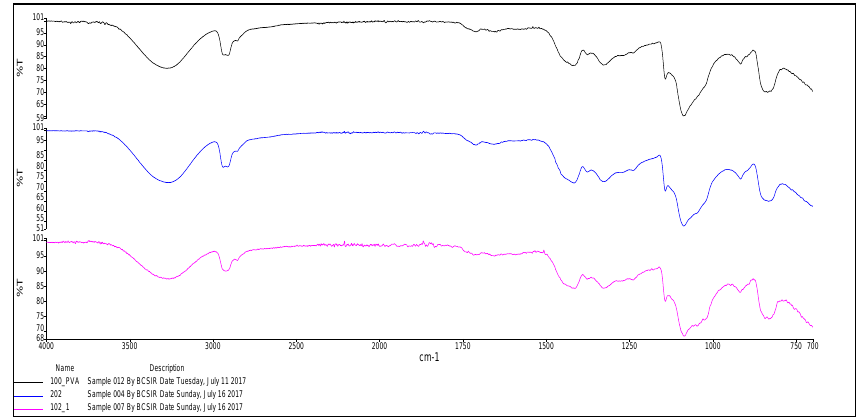
Figure 2. FTIR spectra of cellulose (upper), nanocellulose (middle) and betel nut husk fiber (lower).